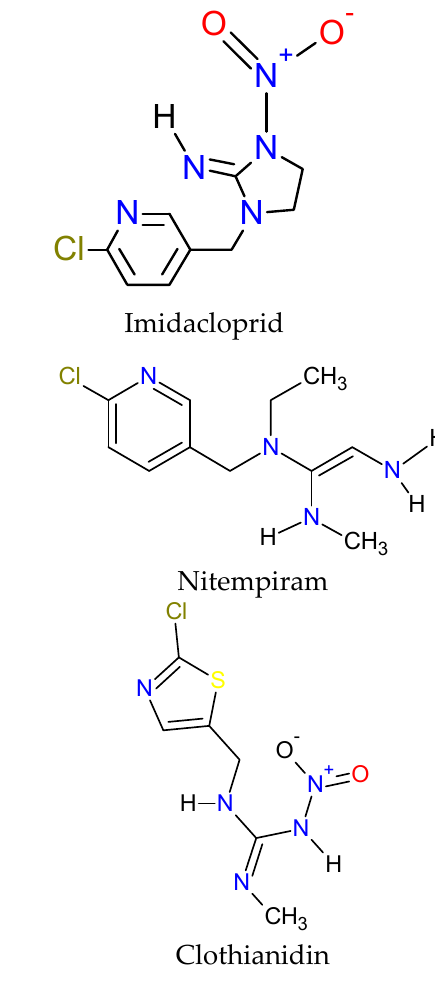
Figure 5. Structural formula of some neonicotinoids.